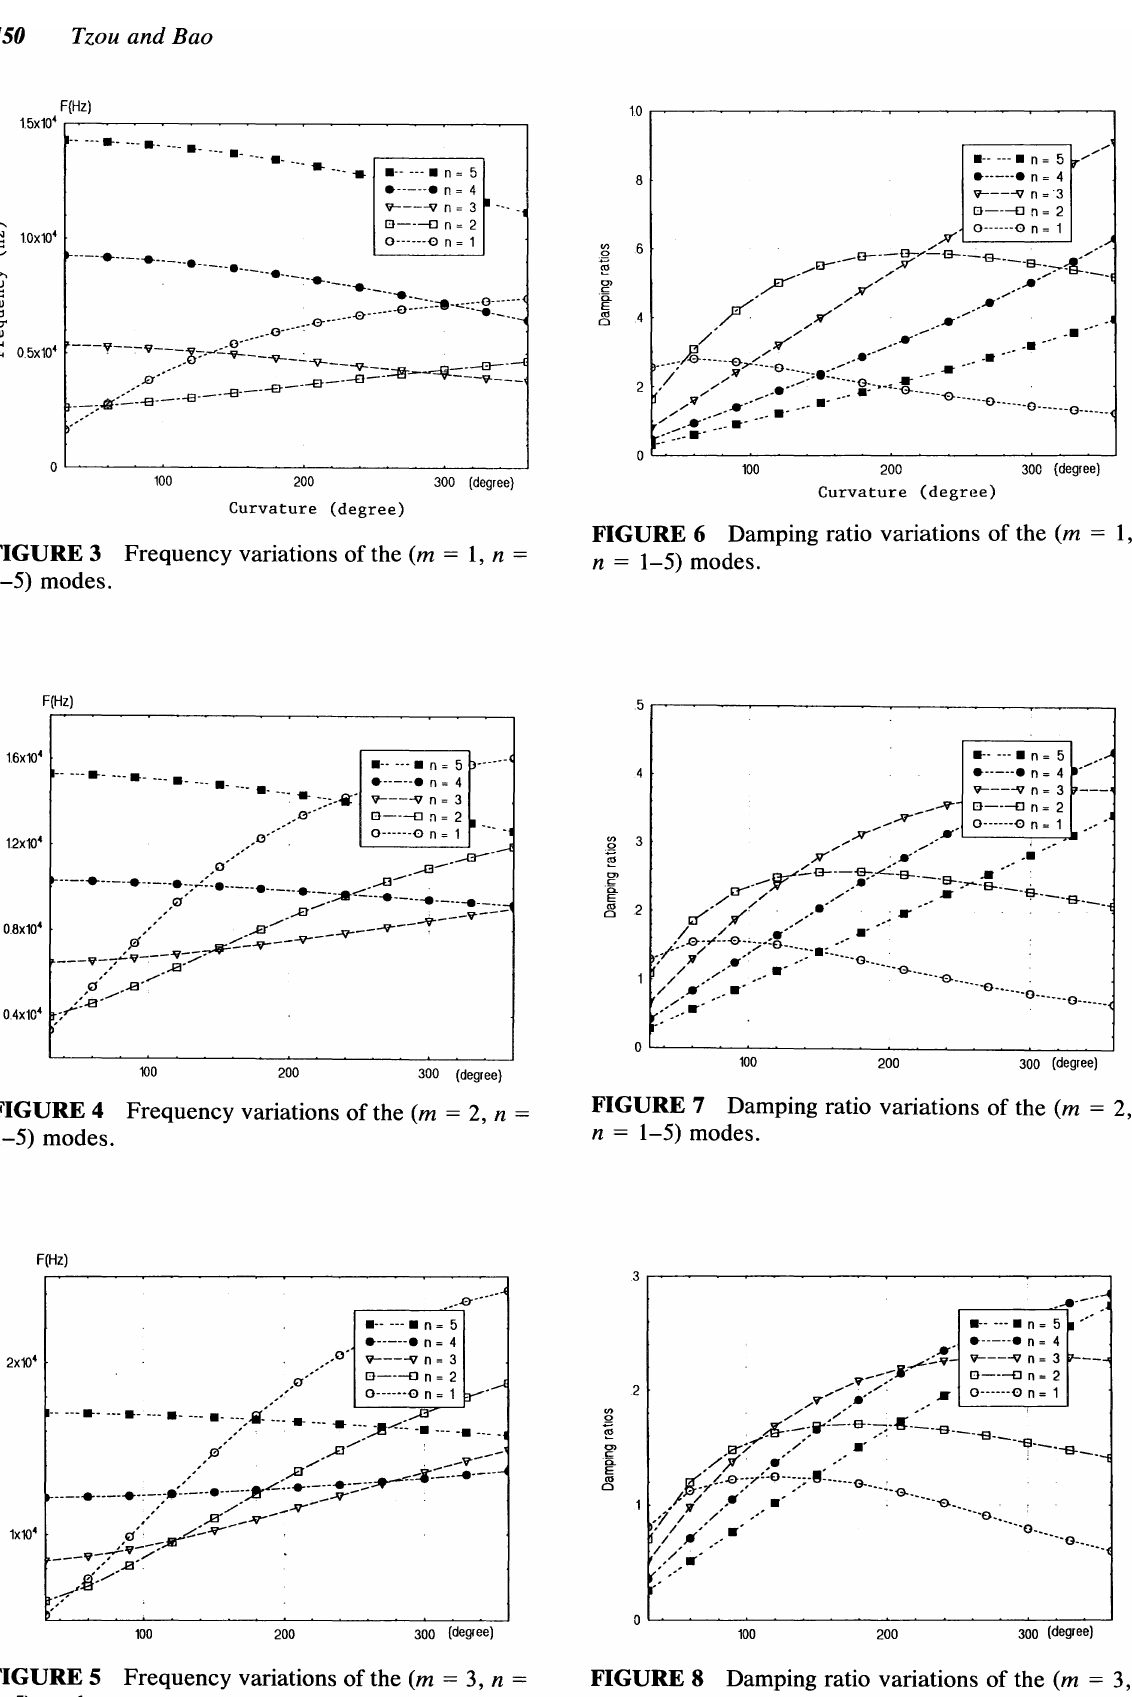
FIGURE 8 Damping ratio variations of the (m n = 1-5)